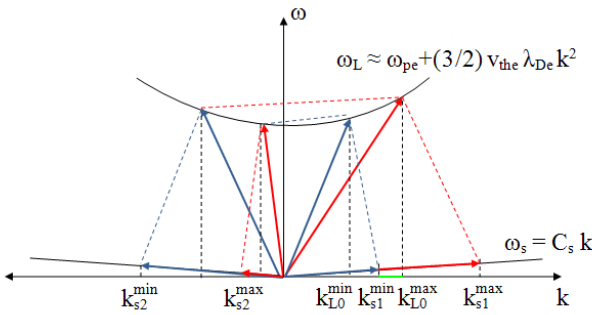
Fig. 1. Simplified schematic of the parametric decay.